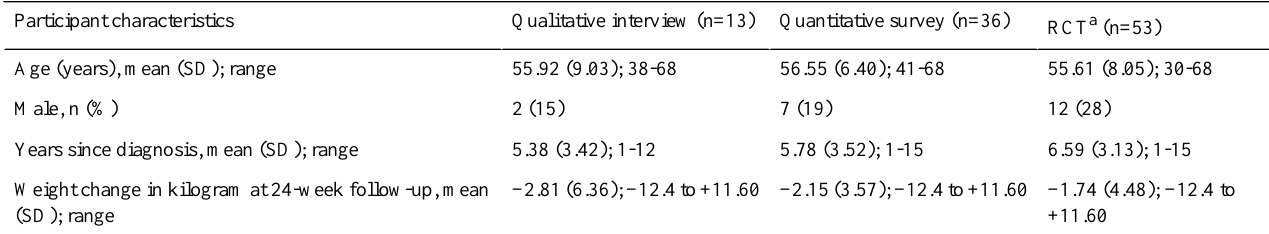
Table 2. Descriptive characteristics of participants in this mixed-methods study and in the intervention group of the full